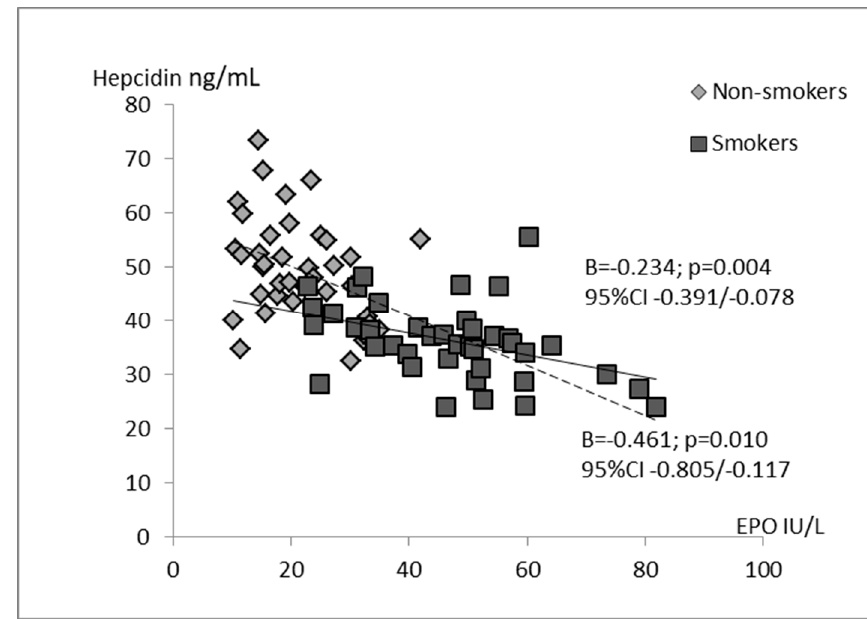
Figure 1. Univariate regression analyses of hepcidin with erythropoietin in the groups of smoking women’s newborns ( n = 40) and non-smoking women’s newborns ( n = 40).